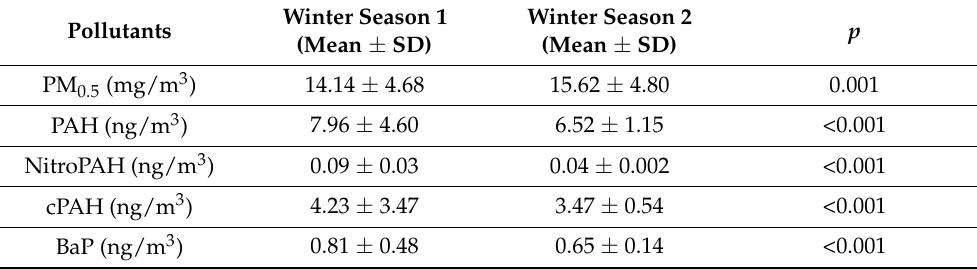
Table 3. Mean concentration ( ± SD) of PM 0.5 , PAHs (polycyclic aromatic hydrocarbons), nitroPAHs, cPAHs (carcinogenic PAHs) and BaP (benzo(a)pyrene) measured in PM 0.5 collected with a high- volume air sampler near the schools attending by the children (five samples for each season).